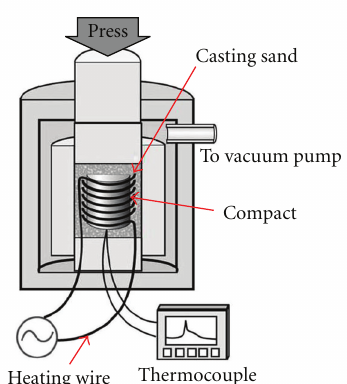
Figure 1: Schematic illustration of the pseudo-HIP equipment.